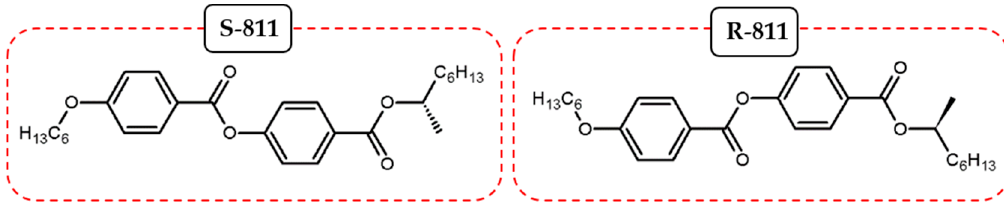
Figure 10. The chiral dopants in addition to azobenzene monomers and crosslinkers used by Iamsaard et al. [78] to prepare liquid crystalline polymers (LCPs).